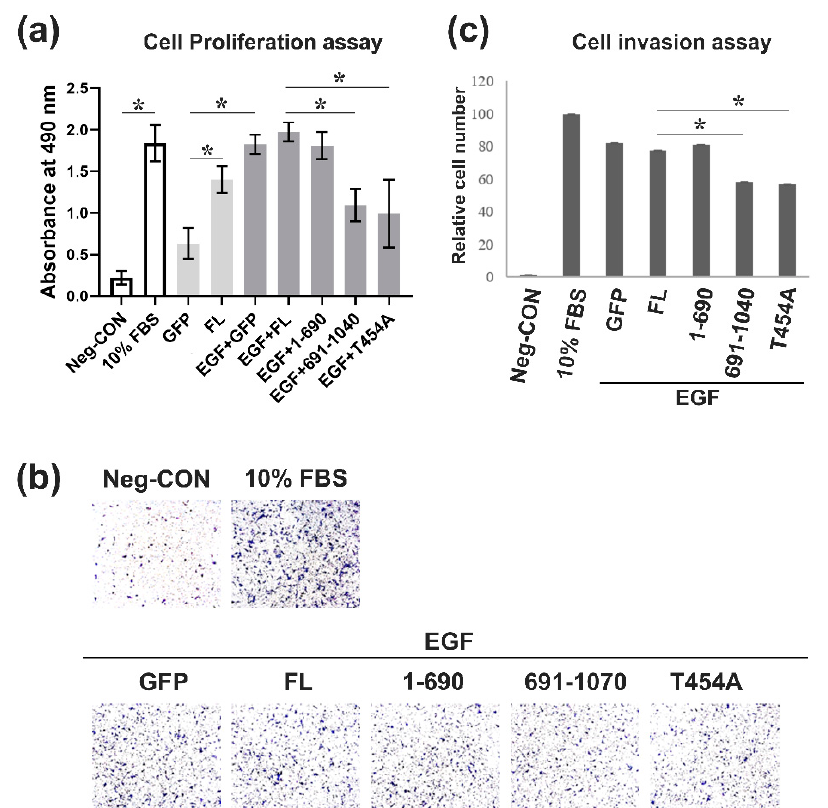
Figure 5. EGF regulates cell proliferation and invasion through AKT/ δ -catenin/p21 signaling independently. ( a ) Rv-1 cells were transfected with the respective plasmid and then seeded into a 96-well plate. After 12 h, transfected cells were then serum-starved and then treated with 100 ng/mL EGF or 10% serum for 12 h. After cells were incubated with the CCK8 reagent at 37 °C for 4 h, plates were read at 490 nm to obtain absorbance values. This experiment was repeated independently five times. ( b ) A transwell assay was performed with Rv-1 cells transfected with the respective plasmid and treated with EGF 100 ng/mL. This experiment was repeated independently five times. ( c ) The quantitation results of positive cells are shown in ( b ). All p -values were determined with unpaired Student’s t -test: *, p < 0.001.